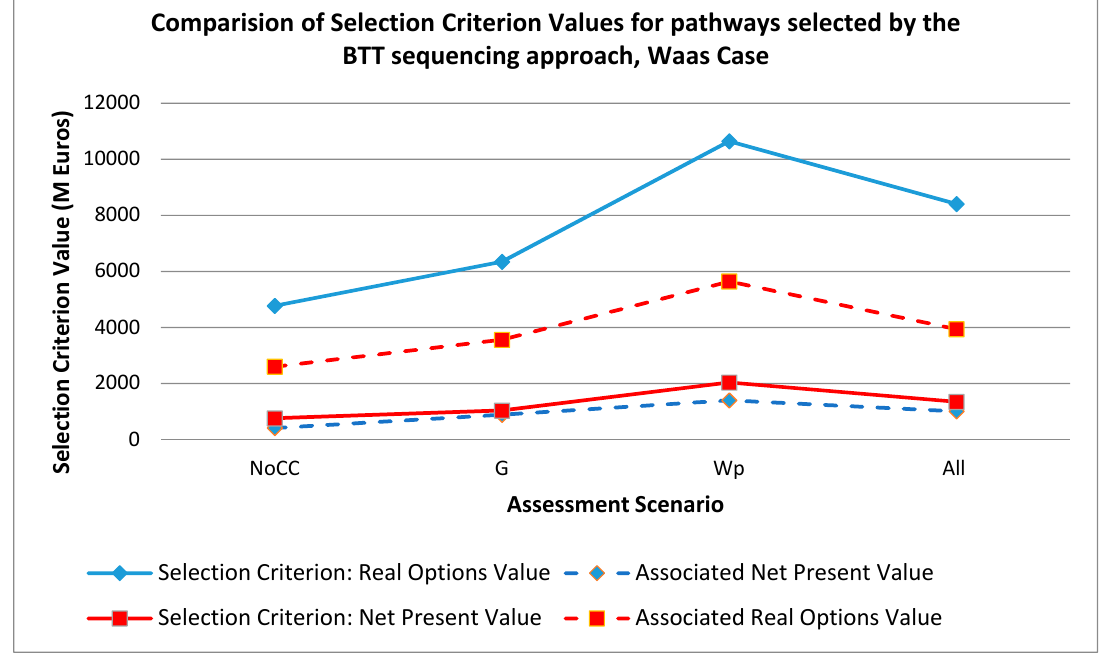
Figure 9. Comparison of Selection Criterion Values for pathways selected by the BTT sequencing approach under different assessment scenarios, Waas Case. Water 2018 , 10 , x FOR PEER REVIEW